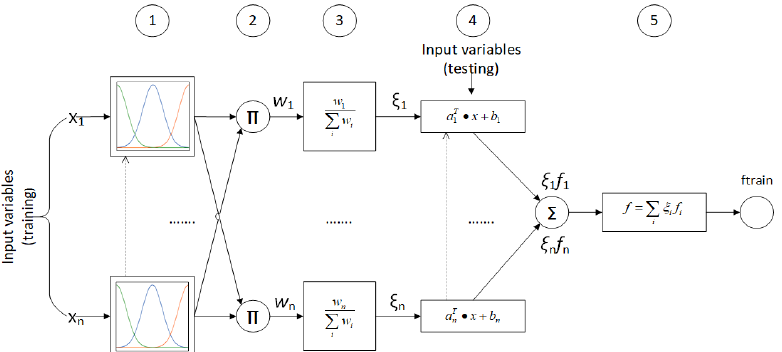
Figure 4. The basic structure of ANFIS.